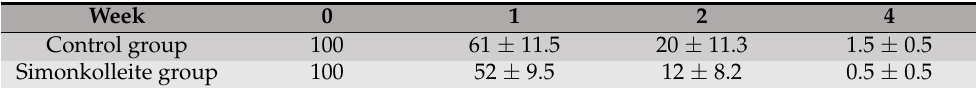
Figure 6. Gross observations of the wounds in the simonkolleite and control groups at each time point. Table 1. Comparison of the proportion of the residual wound between the control and simonkolleite groups after 1, 2, and 4 weeks as determined using the image processing program